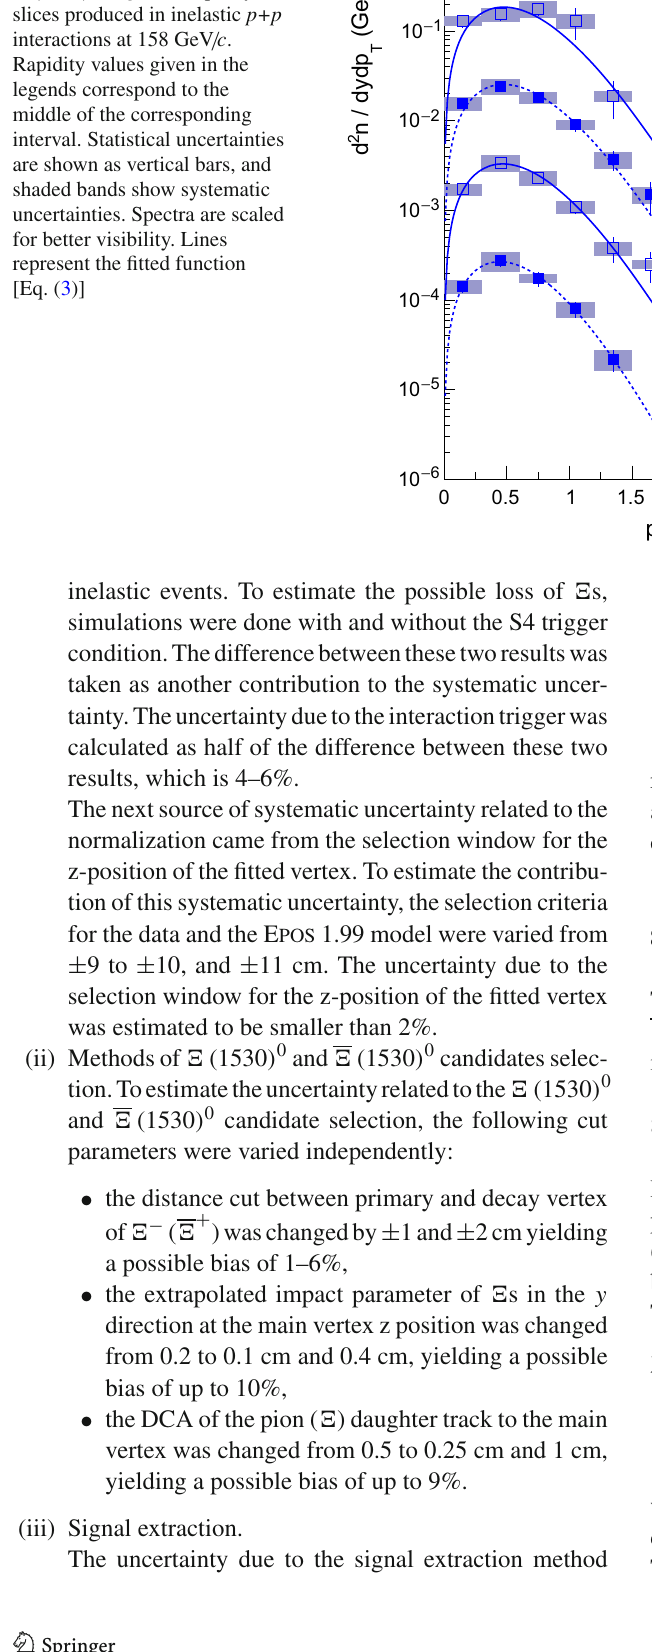
Fig. 7 Transverse momentum spectra of (cid:2)( 1530 ) 0 ( left ) and (cid:2)( 1530 ) 0 ( right ) in rapidity slices produced in inelastic p+p interactions at 158 GeV / c . Rapidity values given in the legends correspond to the middle of the corresponding interval. Statistical uncertainties are shown as vertical bars, and shaded bands show systematic uncertainties. Spectra are scaled for better visibility. Lines represent the fitted function [Eq.